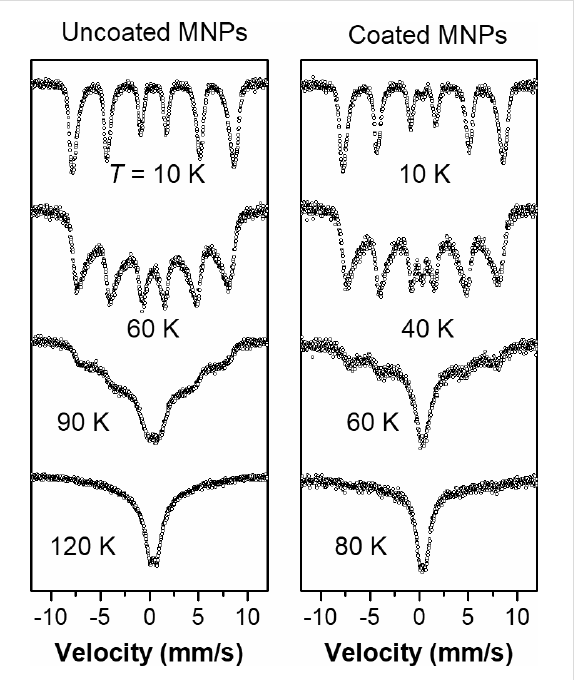
Figure 8: Mössbauer spectra for uncoated and HSA-coated magnetic nanoparticles (MNPs) at temperature ranging from 10 to120 K. The superparamagnetic transition in uncoated nanoparticles is observed at a higher temperature than in coated